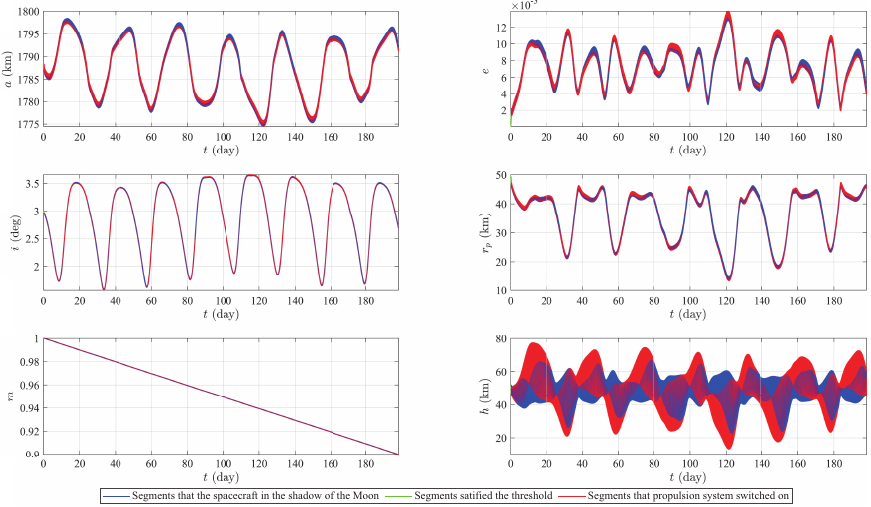
Figure 7. The variation of orbit elements in the process of orbit maintenance with thrust (cid:107) T (cid:107) = 10 mN, Ω = 240 ◦ and i = 3 ◦ .